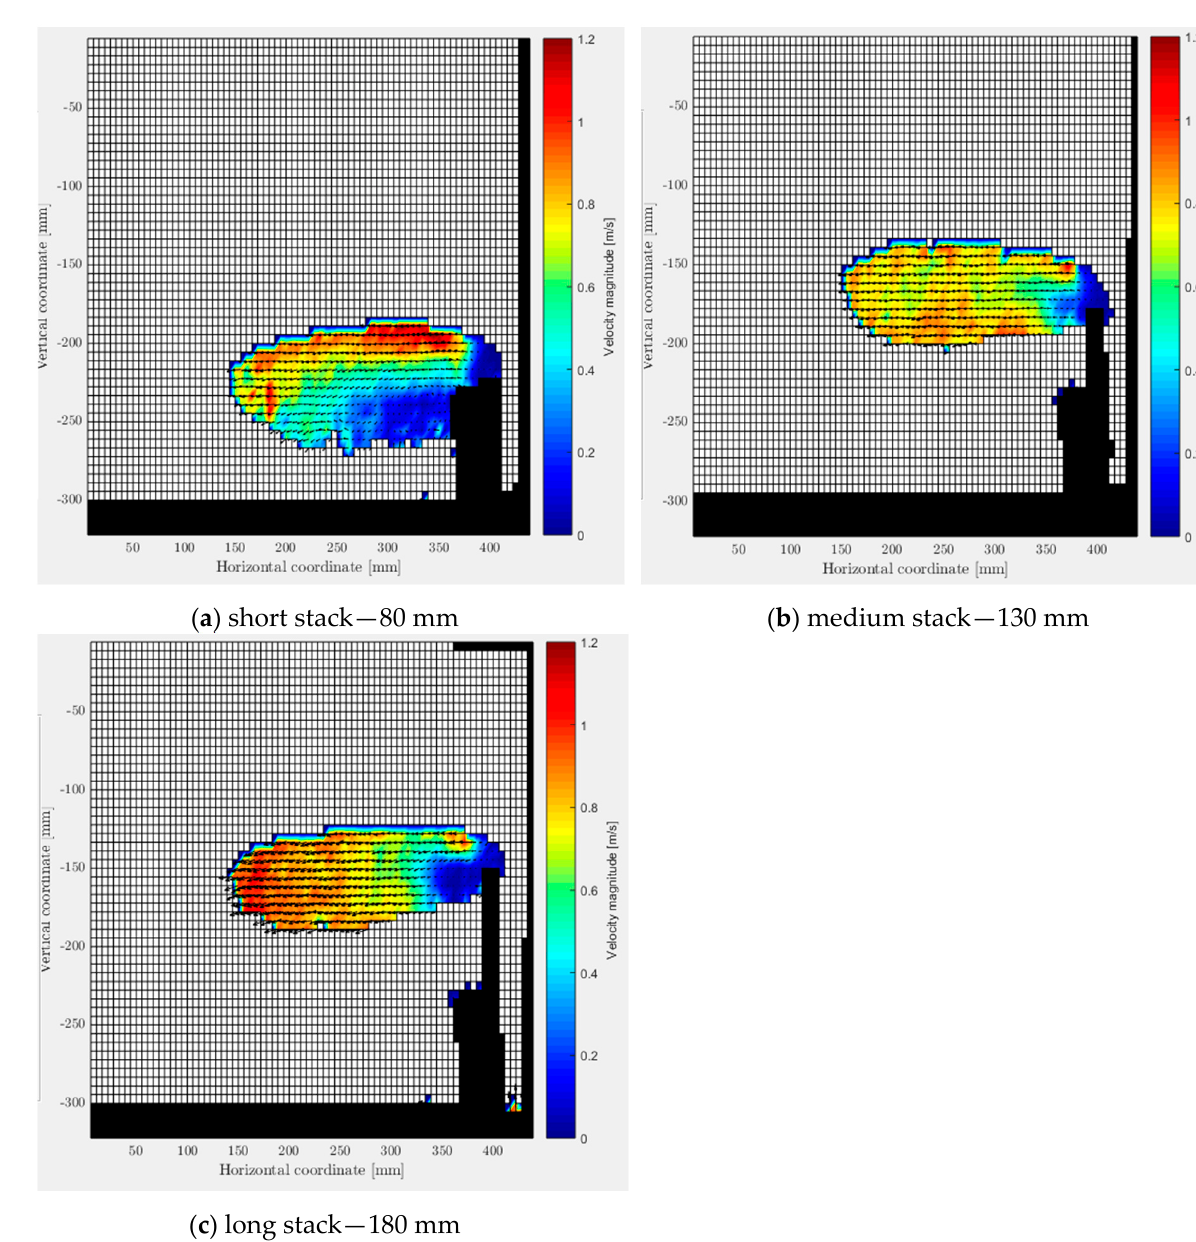
Figure 7. Wind velocity field results to assess the height of stack effects on the exhaust smoke dispersion for an inflow condition of 1 m ∙ s − 1 and a North-Easterly wind direction, using ( a ) short, ( b ) medium and ( c ) long stacks.